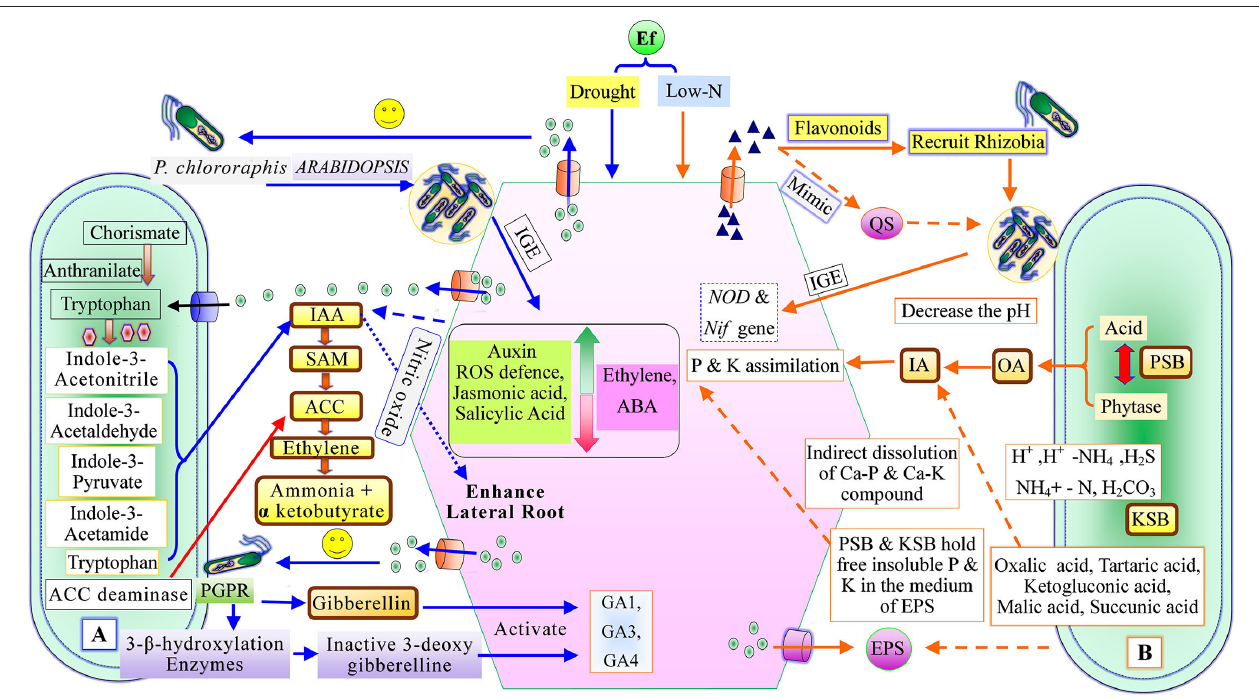
FIGURE 2 | Plant growth-promoting mechanism of recruited plant growth-promoting rhizobacteria, (A) Phytostimulation, and (B) Biofertilizer activity [QS, Quorum sensing; IAA, indole-3-acetic acid; SAM, S-adenosyl methionine; ACC, 1-aminocyclopropane-1-carboxylate; IGE, Induce gene expression; ABA, Abscisic acid; GA1, GA2, and GA4, (Types of gibberellin); PSB, Phosphate solubilizing bacteria; KSB, Potassium solubilizing bacteria; EPS, exo-polysaccharides; OA, Organic acid; and IA, Inorganic